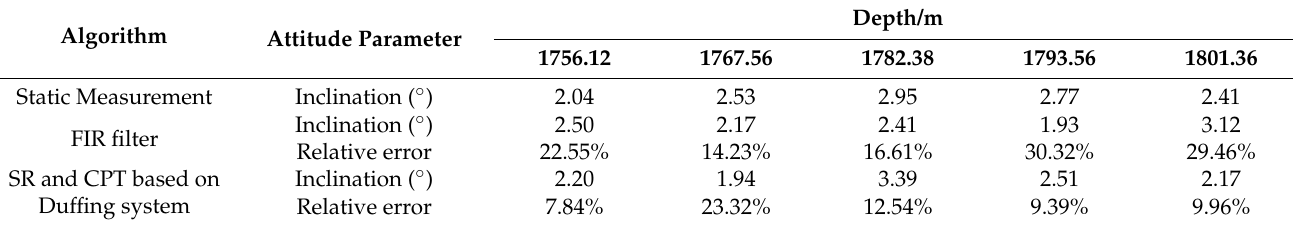
Table 6. Error statistics of the attitude